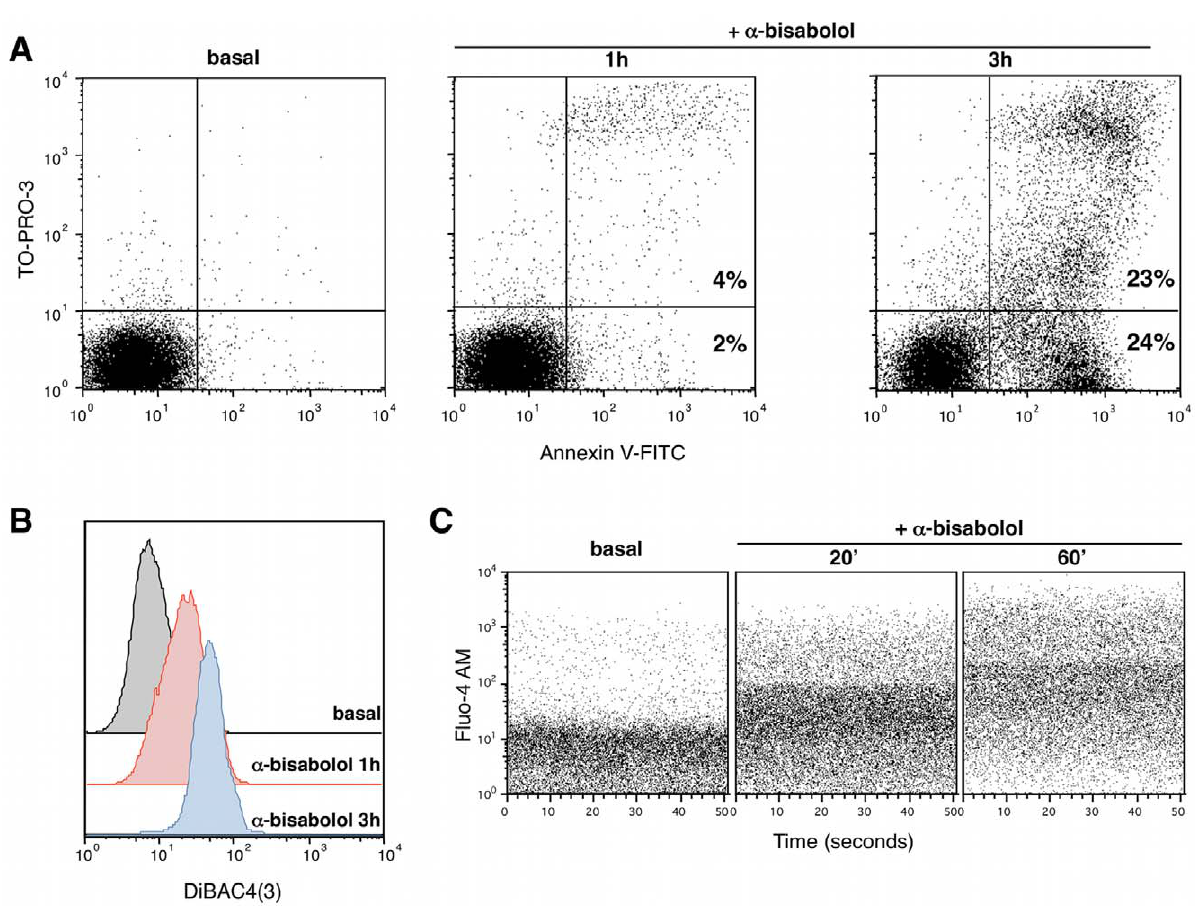
Figure 5. a -bisabolol caused rapid loss of plasma membrane integrity in BCR-ABL + cells (CML-T1 cell line). (A) Cells were treated with 80 m M a -bisabolol for 1 and 3 hours, then stained with Annexin-V and TO-PRO-3 to distinguish between unaffected cells (AnxV neg TO-PRO-3 neg ), early apoptosis (AnxV pos TO-PRO-3 neg ) and late apoptosis (AnxV pos TO-PRO-3 pos ). (B) Time-dependent increase of cell fluorescence after incubation with a - bisabolol and DiBAC(4)3 anionic dye, indicating the depolarization of plasma membrane. (C) Increase of intracellular Ca 2 + concentration revealed by the Ca 2 + indicator Fluo-4 AM already after 20 minutes treatment with a -bisabolol, thus confirming the rapid loss of homeostatic plasma membrane impermeability. Each shown experiment is representative of 5.